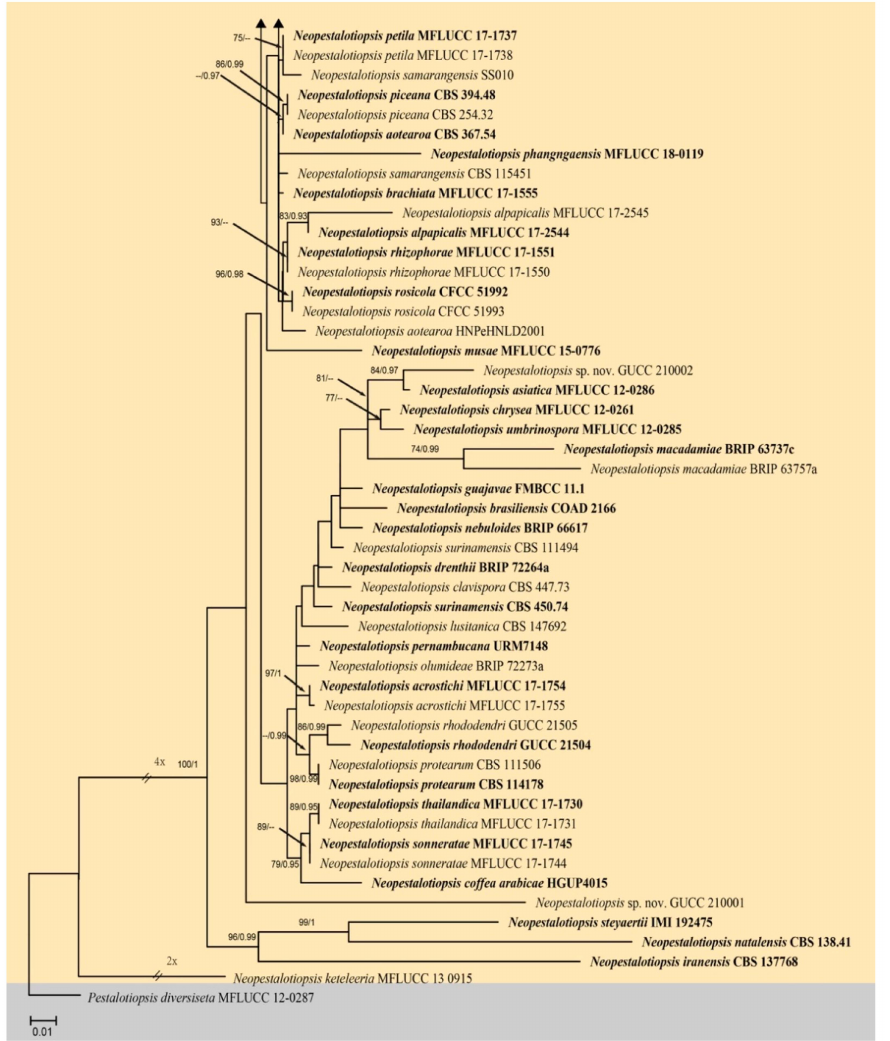
Figure 2. Phylogram generated from RAxML analysis based on combined ITS, tef1- α , and tub2 sequence data of Neopestalotiopsis isolates. The tree was rooted to Pestalotiopsis diversiseta (MFLUCC 12-0287). The ML, MP bootstrap supports ( ≥ 60%) and BI posterior probabilities ( ≥ 0.90 PP) supports are given near the nodes, respectively. Isolates from this study are marked in red and ex-type strains are marked in